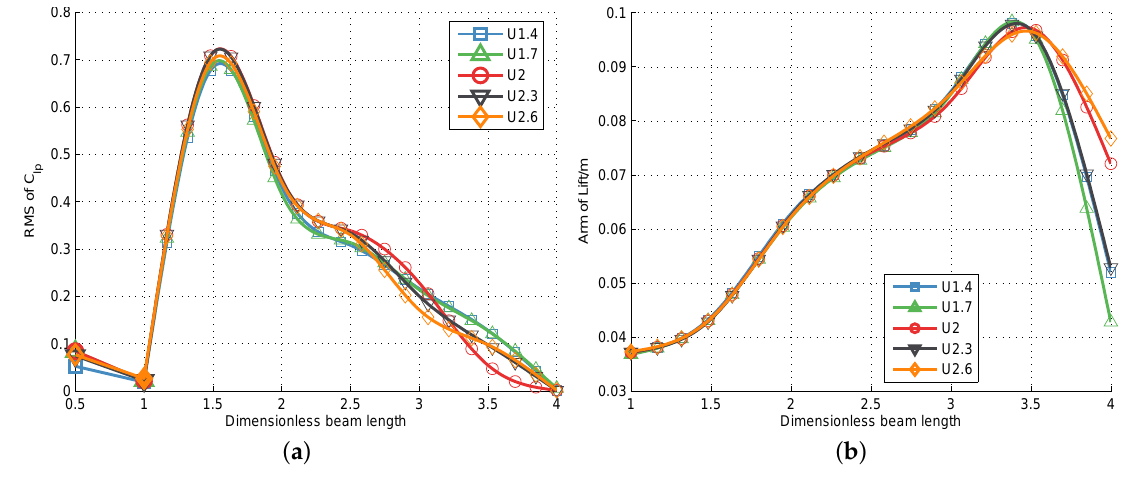
Figure 10. Variation of ( a ) RMS of C lp and ( b ) the arm of C lp versus the dimensionless plate